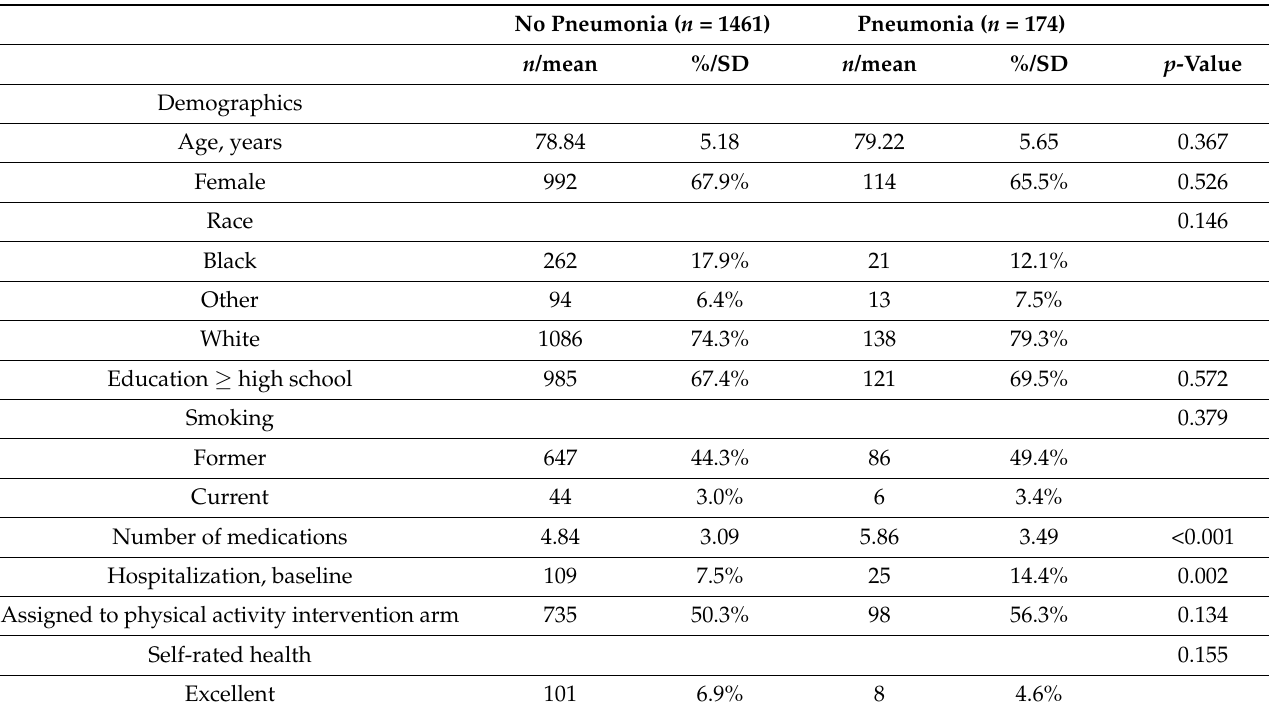
Table 1. Baseline demographic and characteristic comparison between those with and without a pneumonia event during